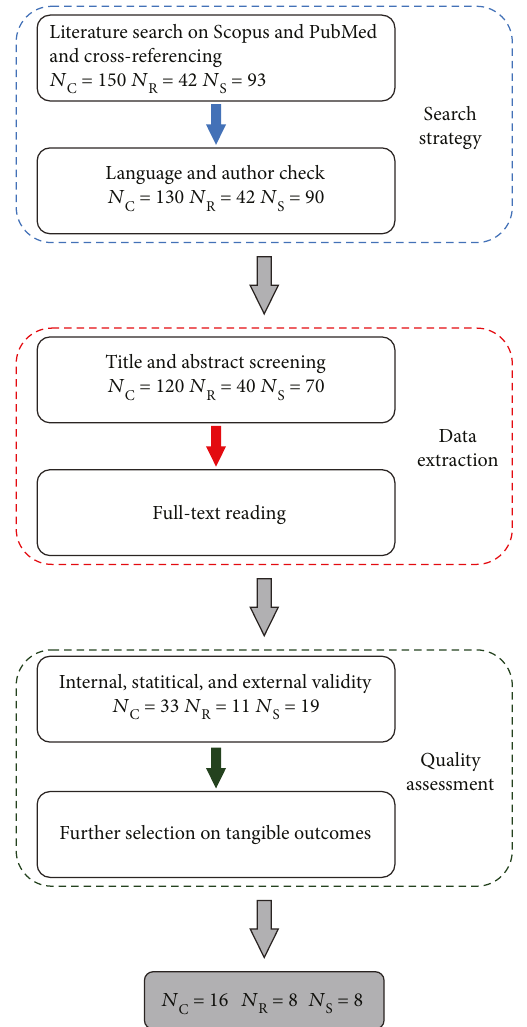
Figure 1: Flowchart of the systematic review process. N N stand for number of papers in the clinics, robotics, and sports S sections,